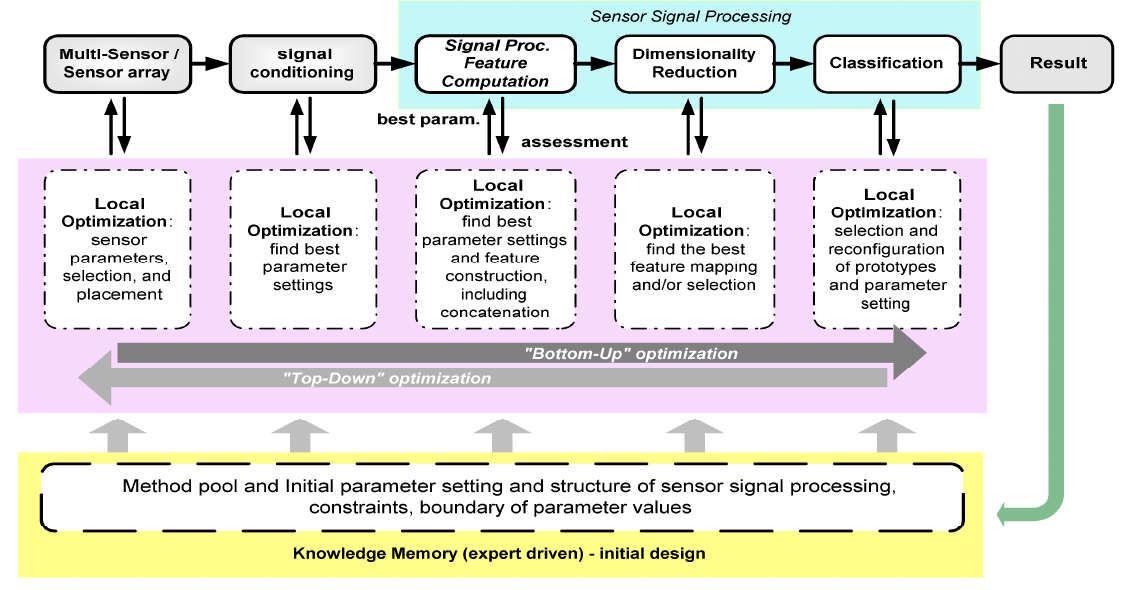
Figure 3. The concept of intelligent multi-sensor system design based on local